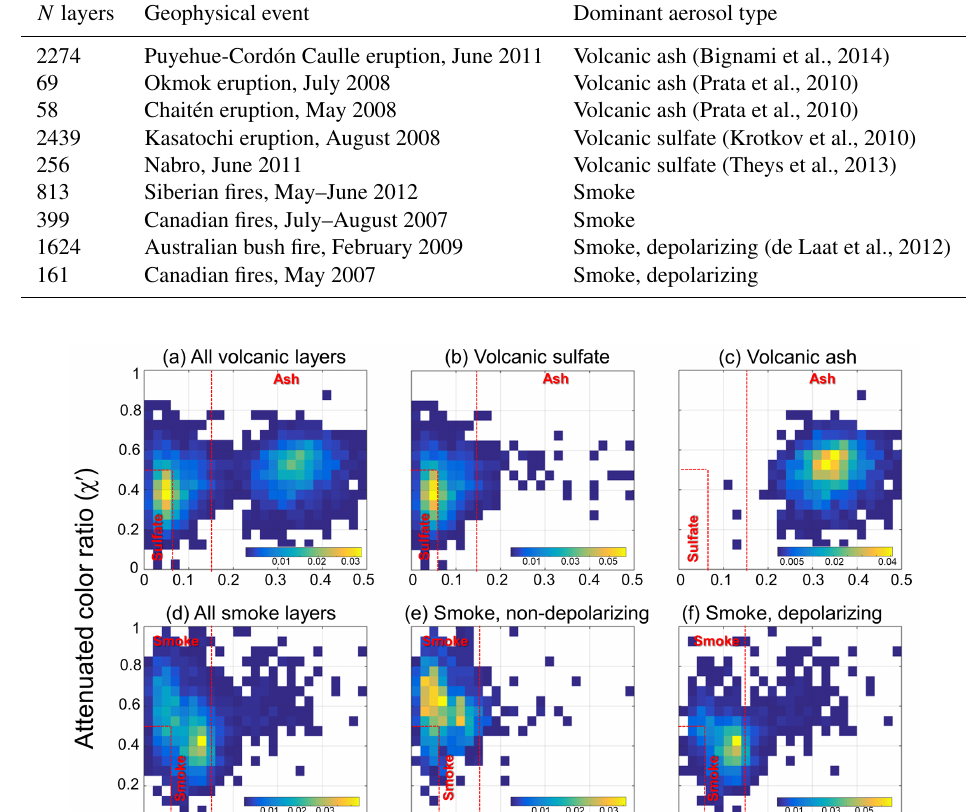
Table 1. Number of layers detected by CALIOP used to determine V4 stratospheric aerosol typing thresholds. The dominant aerosol type for volcanic events is determined according to the references given in the table.